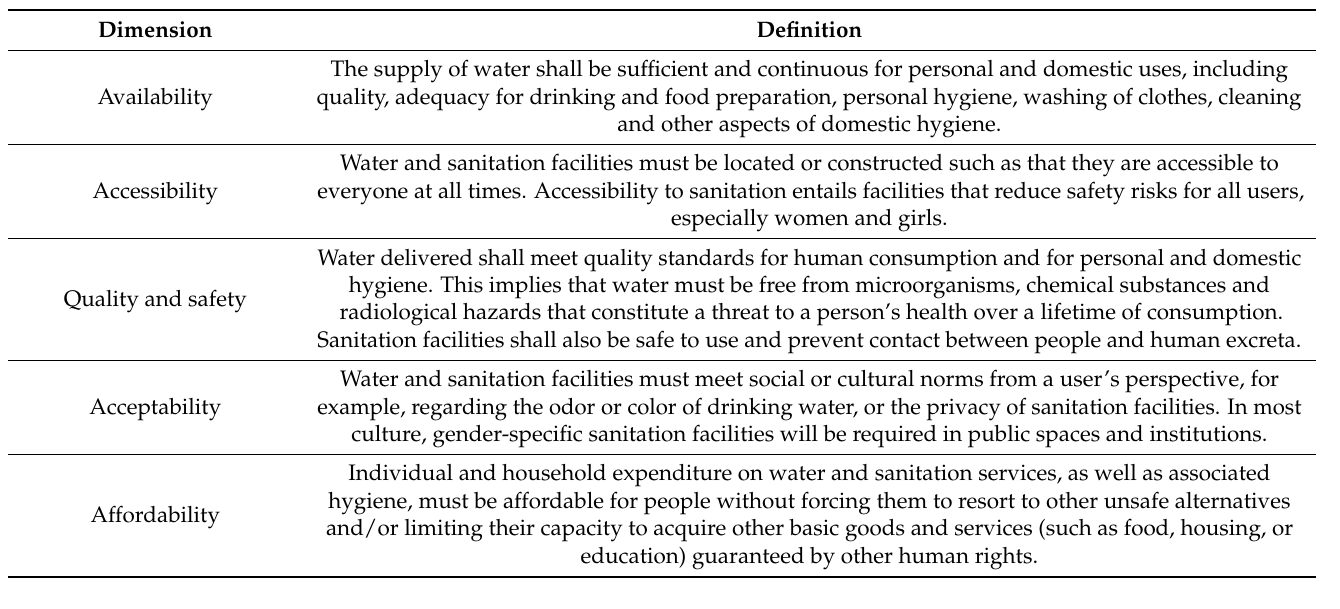
Table A1. The five service dimensions recognized by the HRBA as necessary to guarantee that WASH is delivered and preserved as a human right Adapted from: UN General Comment 15